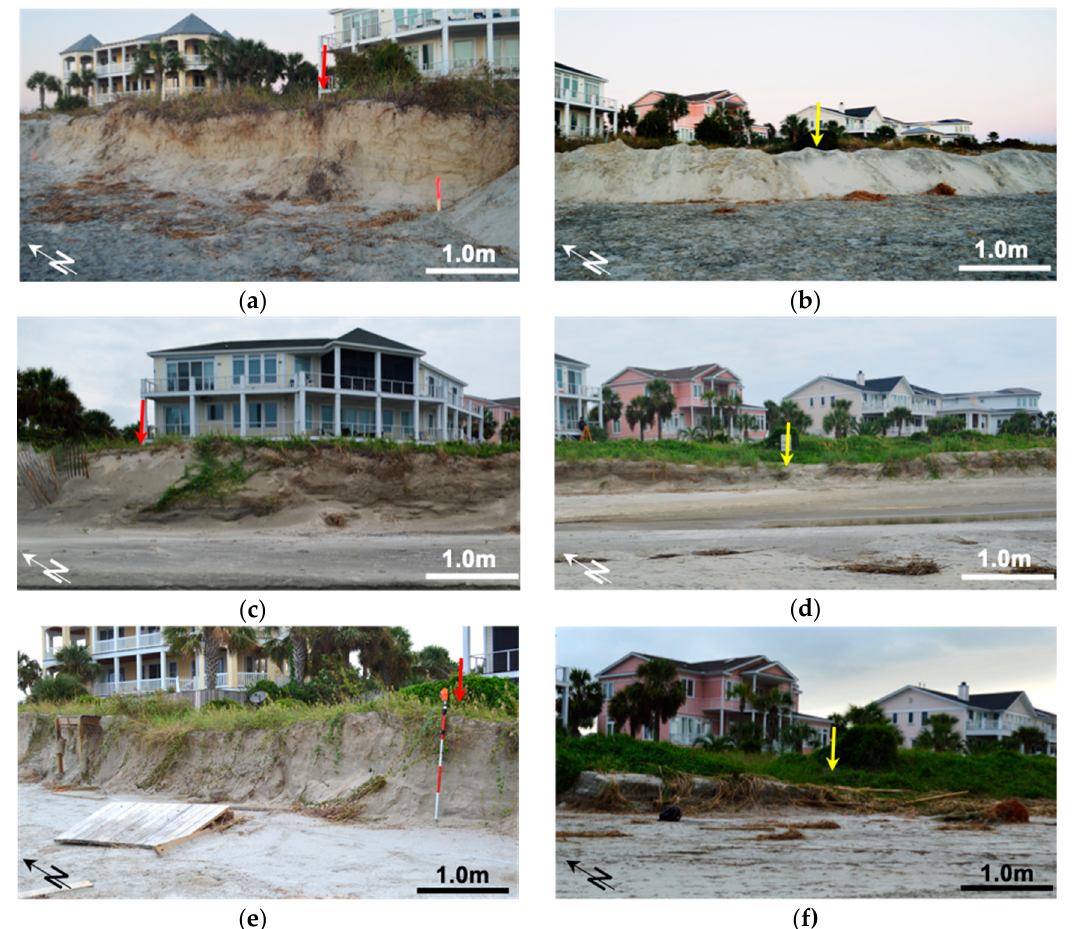
Figure 3. Images of the natural ( a, c, e ) and mechanical dune ( b, d, f ) following Hurricane Matthew shortly following the establishment of the mechanical dune (10/28/16; ( a ) and ( b )), after approximately 10 months of recovery (09/07/17; ( c ) and ( d )), and following the impact of Hurricane Irma (09/14/17; ( e ) and ( f )) on 09/14/17. Colored arrows point to the same locations.